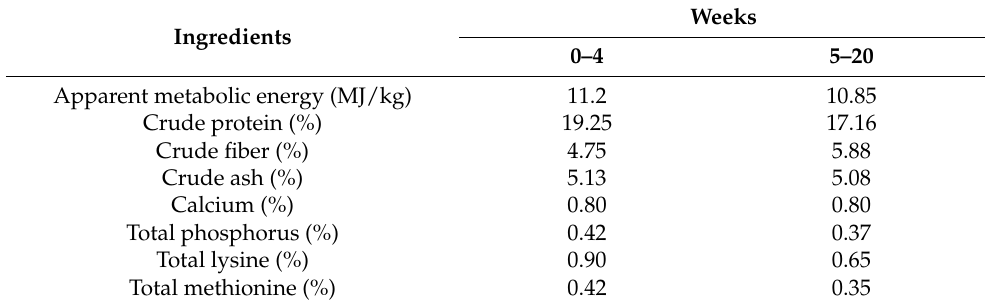
Table 1. Ingredients of the commercial diets provided to the geese at different